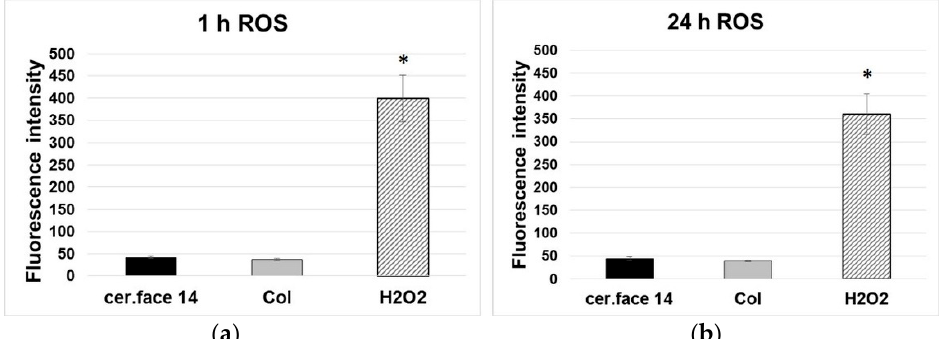
Figure 6. Reactive oxygen species (ROS): non/negligible stress level of osteoblasts on ceramic (cer.face 14), which is comparable with cells on the extracellular matrix protein collagen I (Col) ( a ) after 1 h, ( b ) after 24 h. Cells’ intracellular ROS level is ~9 times higher if stressed with H 2 O 2 as positive control. The amount of ROS in human osteoblasts MG-63 was detected via DCF-DA cellular ROS detection assay kit (Tecan Infinity 200). Statistics: one-way ANOVA posthoc uncorrected Fishers LSD, significance * p < 0.05, n = 3 (independent experimental approaches).